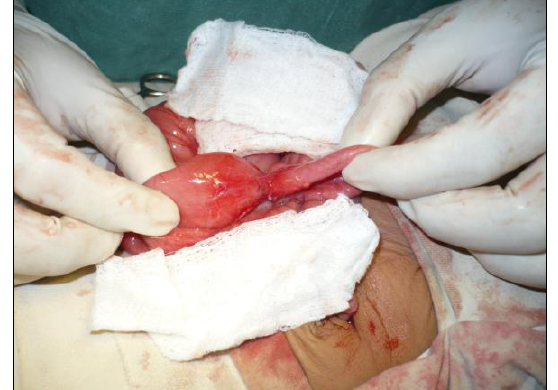
Figure 1: Ileal stenosis.